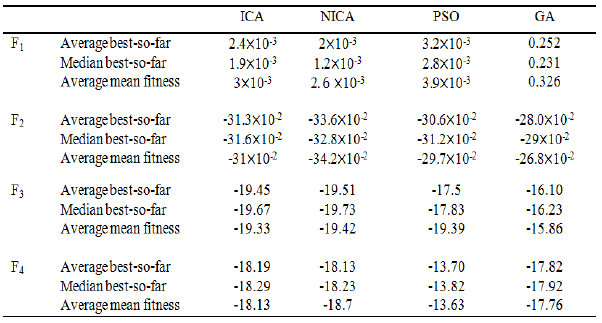
Table 3. Minimization result of benchmark functions in Table 3. Maximum number of iterations =